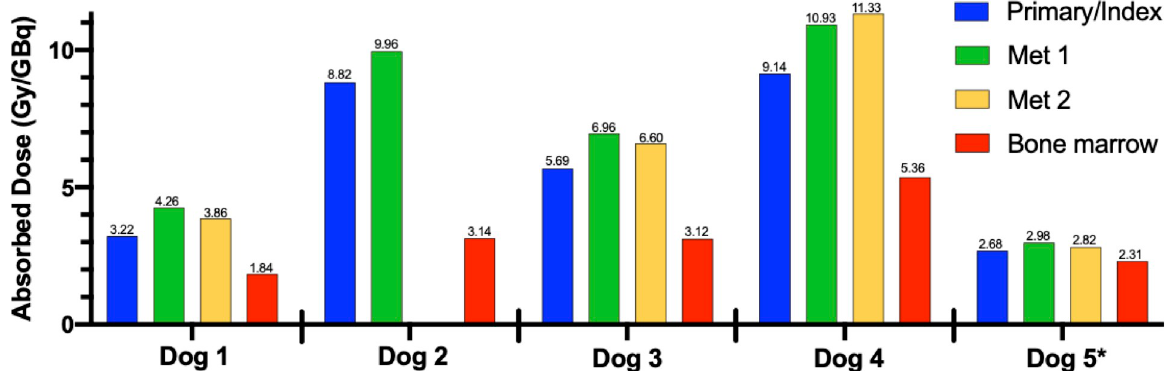
Fig 3. Tissue absorbed dose (Gy/GBq) estimates for 90 Y-NM600 using serial 86 Y-NM600 PET/CT scans and the RAPID Monte Carlo-based analysis platform as described in the Methods section. These estimates were used to determine the 90 Y-NM600 prescription to achieve at least a 2 Gy absorbed dose to all metastatic lesions. Note that four (1–4) of 5 dogs met the a priori requirement for at least a 2:1 metastatic tumor:bone marrow differential uptake ratio. Dog 5 did not demonstrate the 2:1 requirement and was not subsequently treated with 90 Y-NM600 targeted radionuclide therapy.